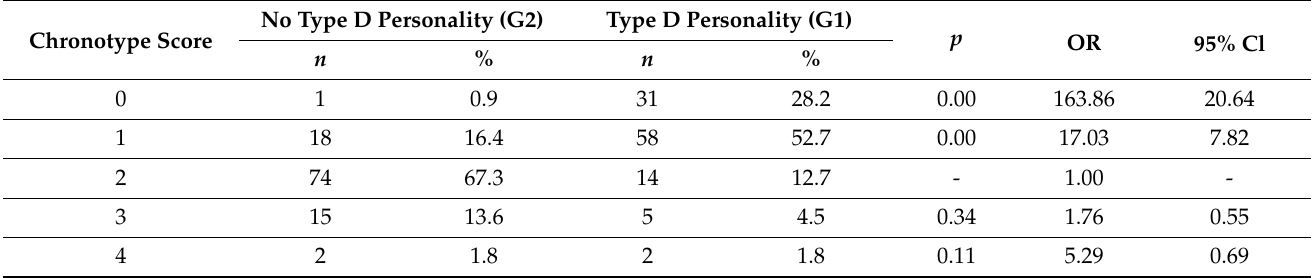
Table 1. Statistical analysis of the chronotypes within the G1 and G2 groups.